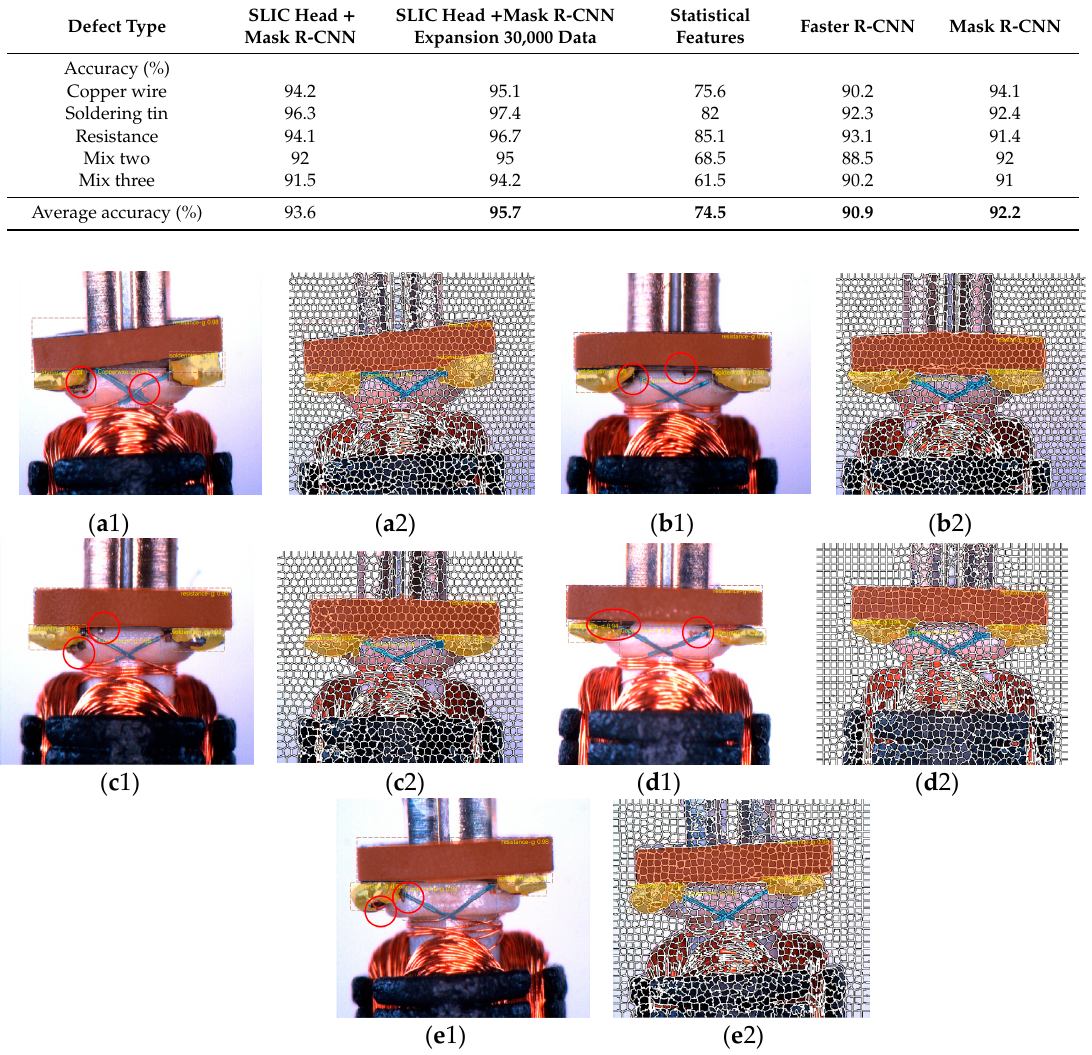
Figure 11. The augmentation e ff ect of the mask in detected areas. ( a1 – e1 ) Examples of inaccurate defect detection due to incomplete mask, ( a2 – e2 ) compare the results of our method for the same